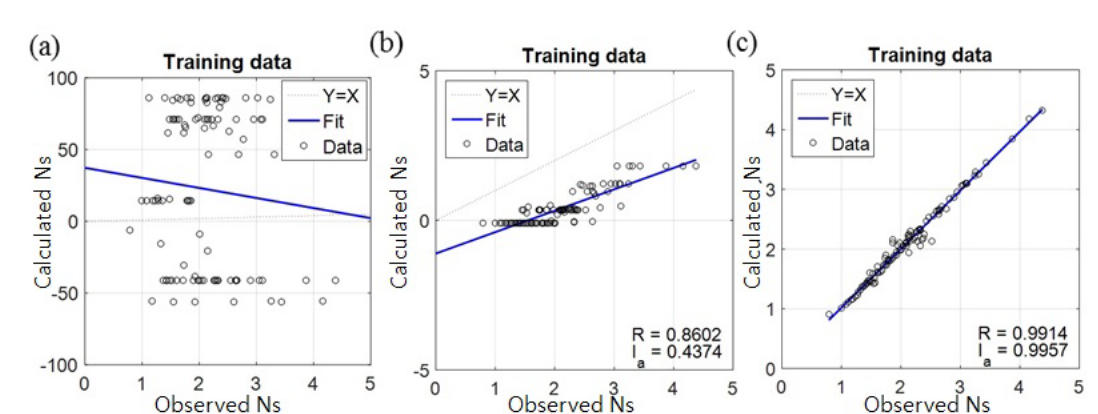
Figure 7. Scatter plots of calculated versus observed stability numbers for Case 1 (HMCR = 0.7; PAR = 0.5): ( a ) randomly selected initial weights; ( b ) optimal initial weights determined by HS algorithm; ( c ) further trained weights after BP algorithm.